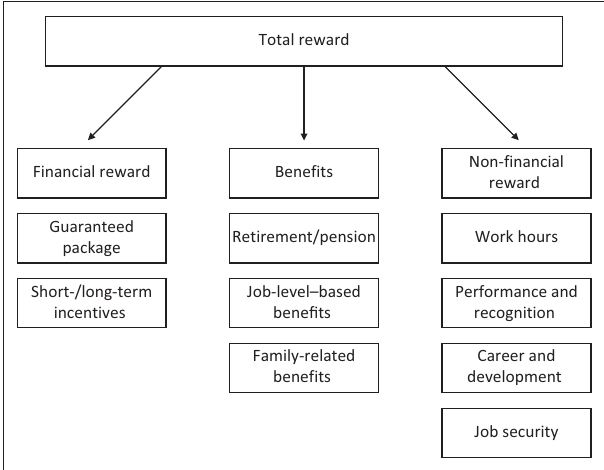
FIGURE 1: Total reward framework adopted in the